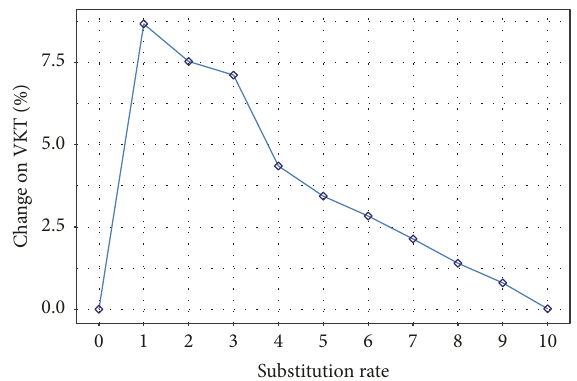
Figure 6: Change on VKTs with respect to base scenario depending on substitution